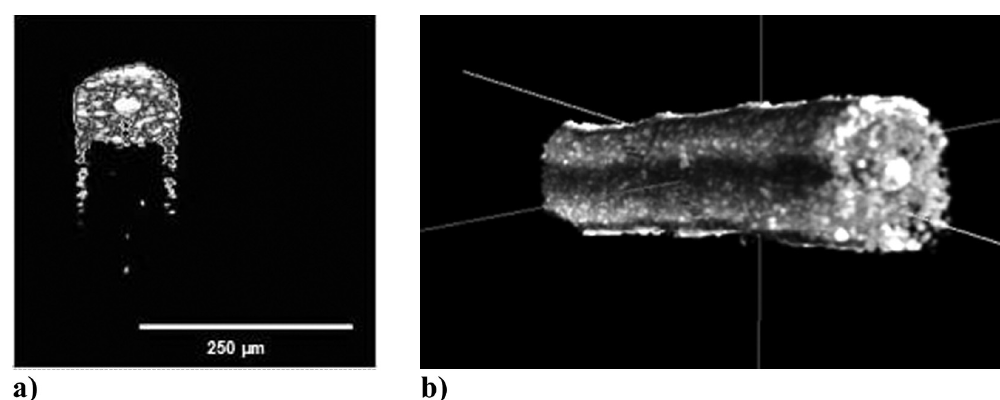
FIGURE 2 - OCT image of an Afro-Ethnic hair sample. In (a) a sample of cross-section fiber and at (b) a tridimensional reconstruction of that fiber, showing the main hair structures: medulla, cortex and